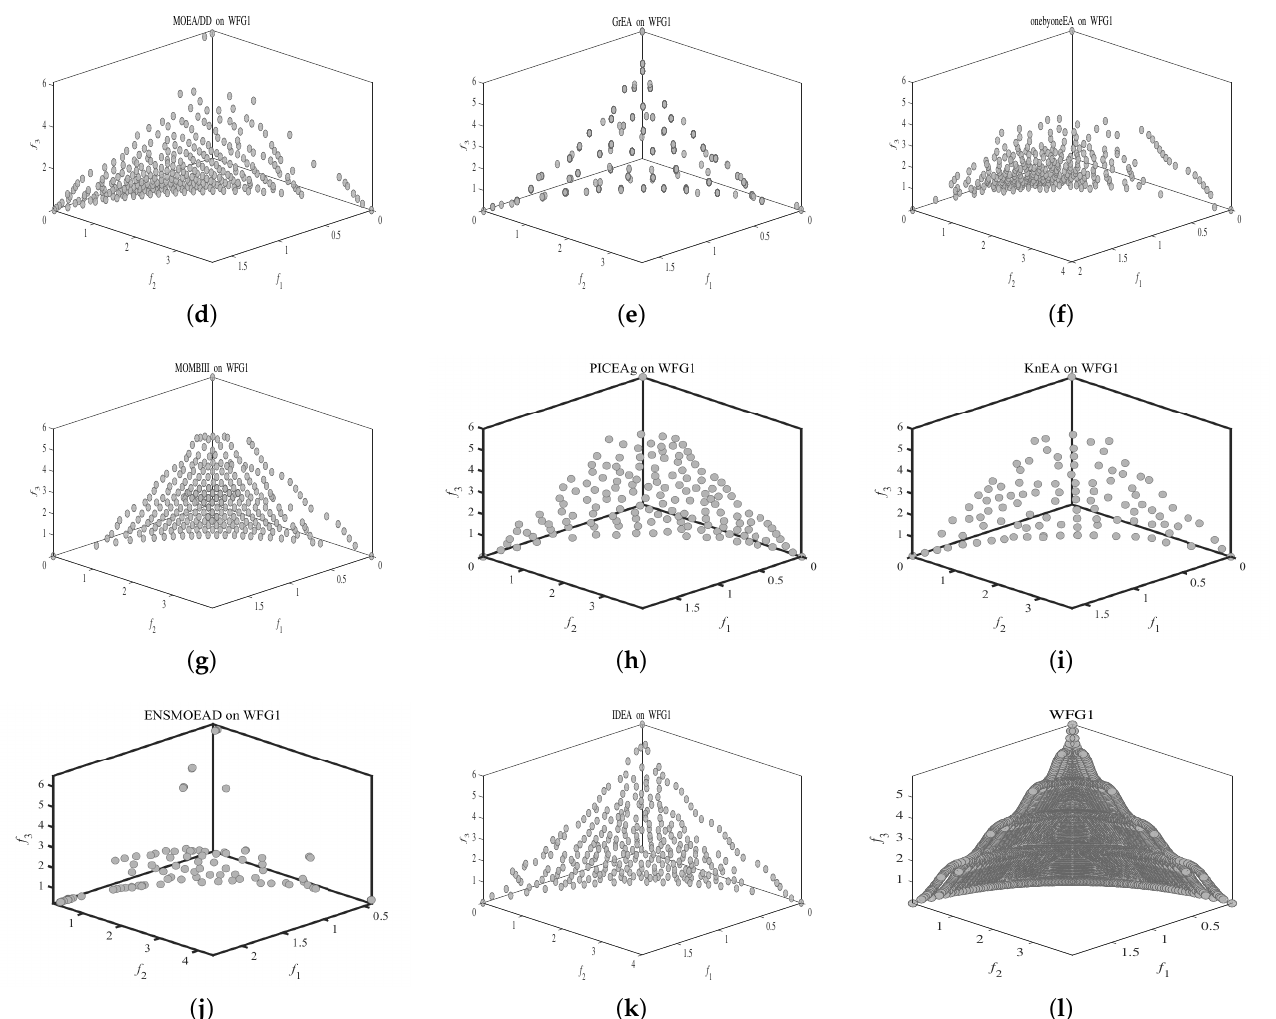
Figure 6. Distribution of the final population for all algorithms on WFG1 problem with 3-dimension. ( a ) NSGA-III. ( b ) RVEA. ( c ) VaEA. ( d ) MOEA/DD. ( e ) GrEA. ( f ) onebyoneEA. ( g ) MOMBI-II. ( h ) PICEAg. ( i ) KnEA. ( j ) ENSMOEAD. ( k ) IDEA. ( l ) True